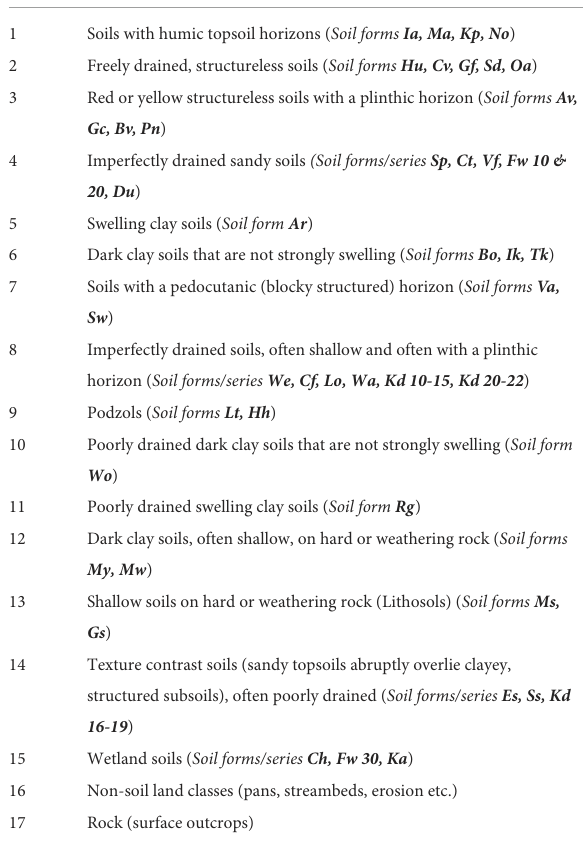
TABLE 3 A generalized description of the soil categories together with the soil forms (symbols in brackets) used in the crop suitability